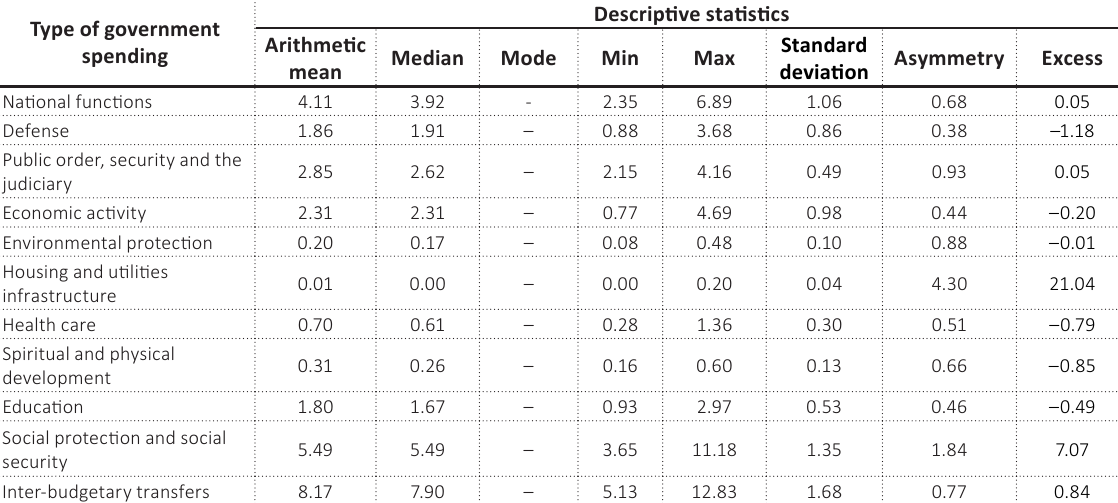
Table 4. Descriptive statistics of government spending in Ukraine, 2010–2019